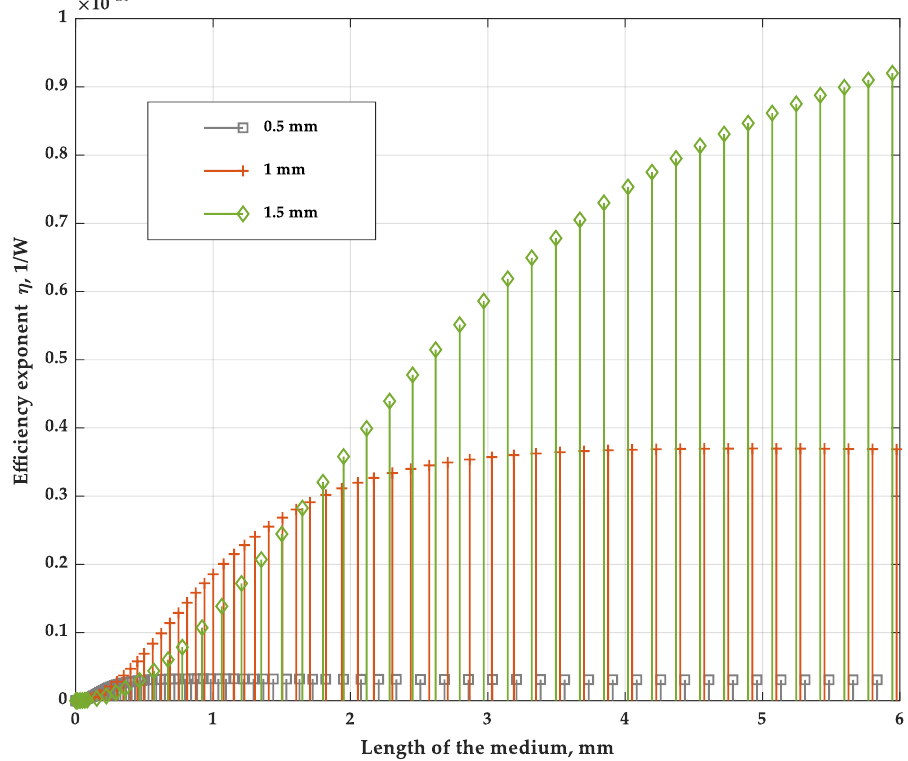
Figure 3. Dependence of the efficiency exponent η of a radio vortex beam on the length of a nonlinear medium z for three values of the waist radius of laser beams.